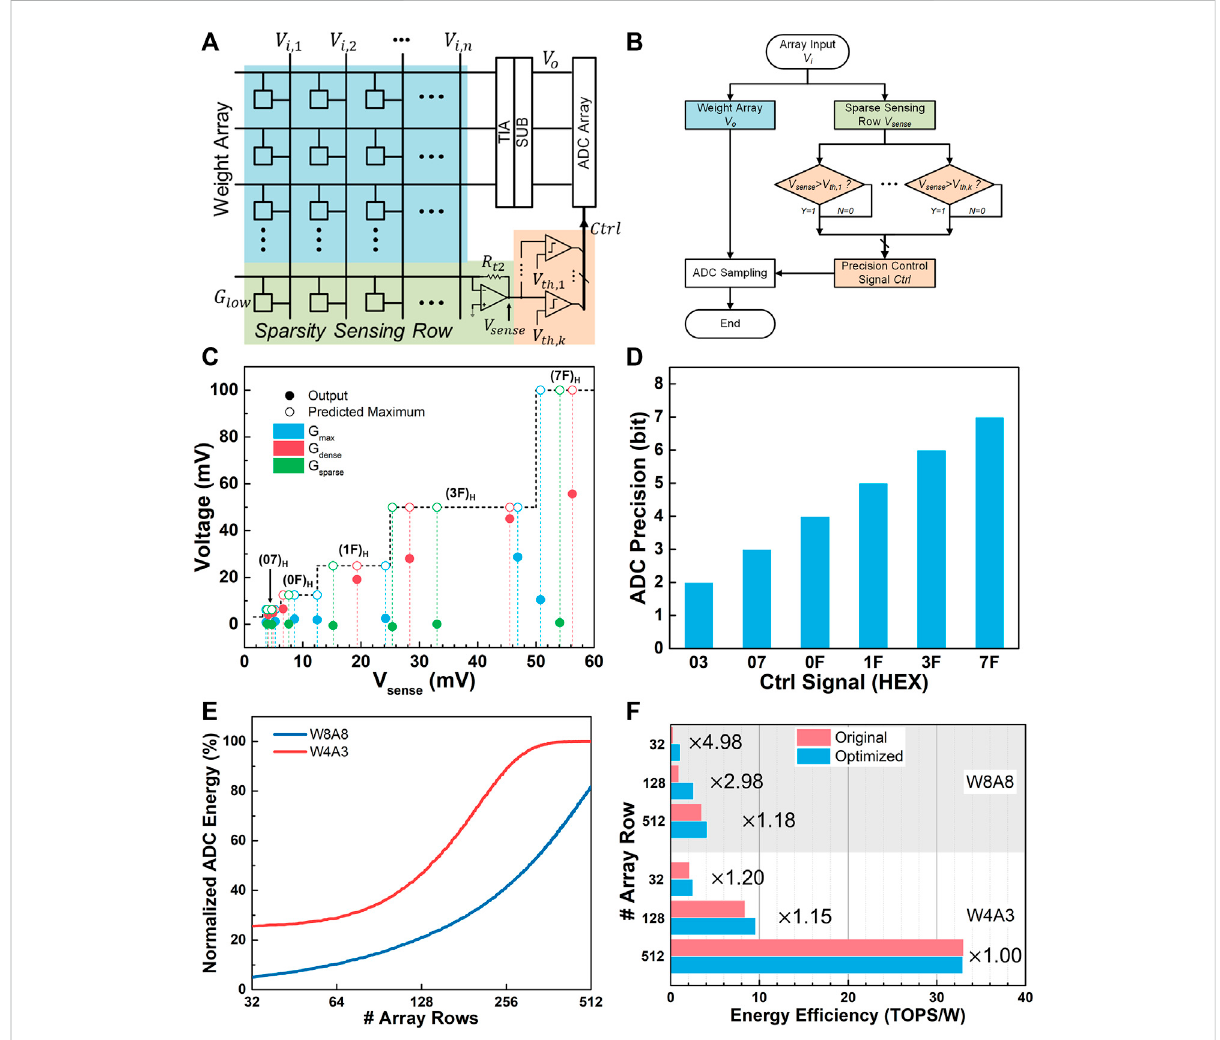
FIGURE 6 Scheme of (A) hardware implementation and (B) the fl owchart of the proposed sparse-aware processing method. (C) Simulation results of the sparsity-aware processing circuit design with respect to different V sense . (D) The con fi guration of the ADC precision according to different Ctrl signals. (E) The normalized ADC energy consumptions that use the proposed sparsity-aware processing method with respect to the array row sizes. (F) Thecomparisonoftheenergyef fi ciencybetweentheoptimizedMACunitswiththesparsity-awareprocessingmethodandtheoriginalones under W8A8 (gray) and W4A3 (white)